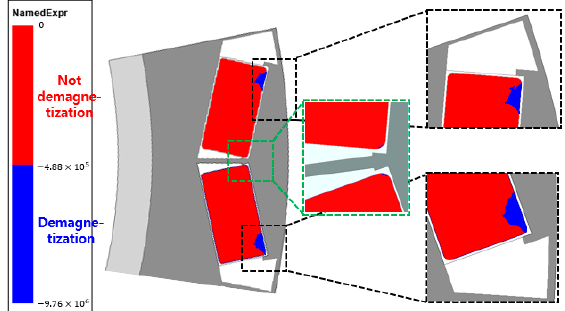
Figure 13. Demagnetization region of the model. The thickness of the steel plate inserted into the barrier and bridge was set at 0.6